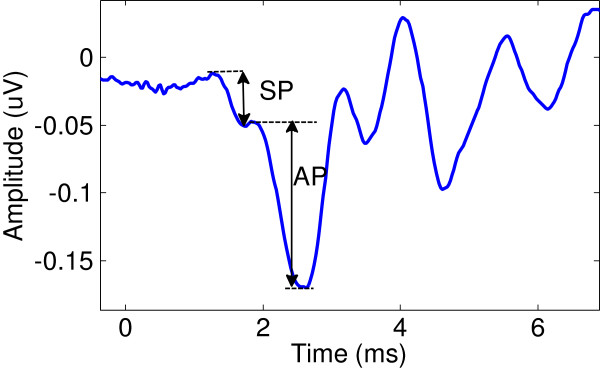
Typical ECOG response.